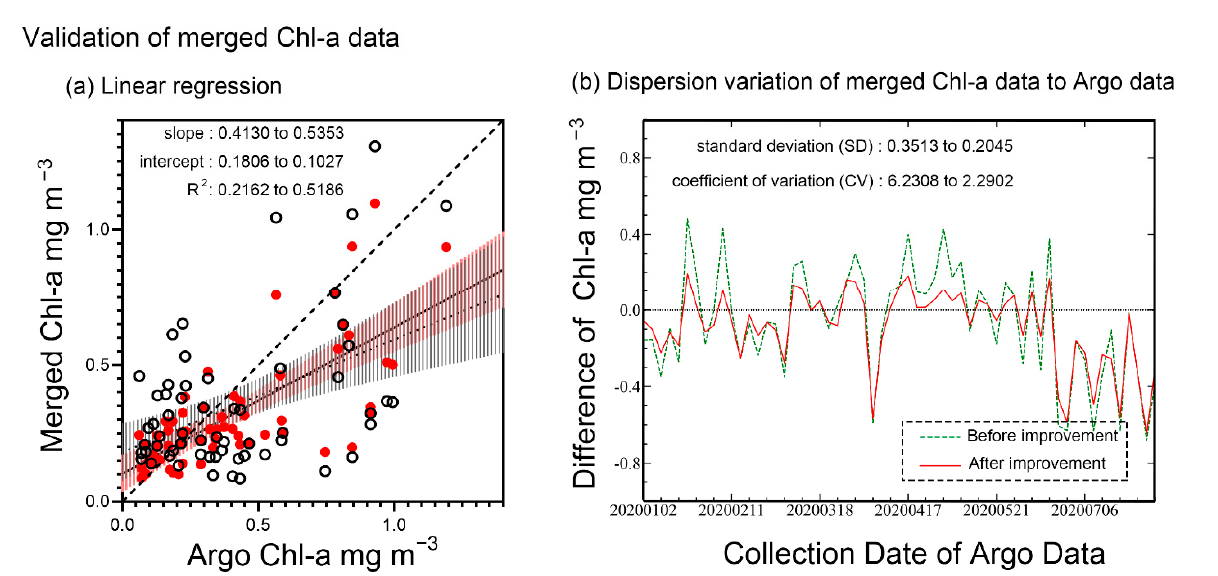
Table 11. Systematic deviation of the Argo data. “All” indicates the total Argo data; “>0.3” and “<0.3” indicate the group data based on a threshold Chl Argo concentration = 0.3 mg m − 3 .